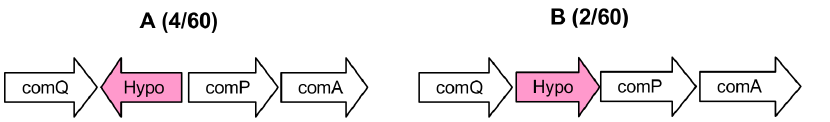
Figure 4. Unusual comQXPA-like loci. (A) Non-canonical unusual com system is present in B. cereus VD102, B. cereus BAG4X12 1, B. cereus MSX A1 and L. fusiformis ZC1. Note that Lysinibacillus is the only genus whose two species have two com loci each: L. sphaericus C3 41 has two canonical loci while in L. fusiformis ZC1 one locus is canonical and the other one is non-canonical, shown here. (B) Canonical unusual com system present in Paenibacillus curdlanolyticus YK9 and B. coagulans 36D1.